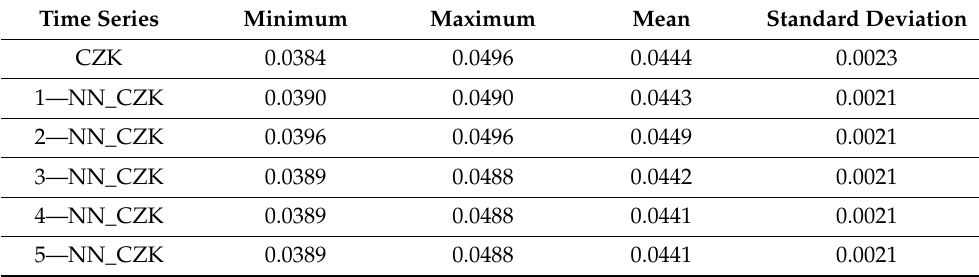
Table 5. Statistical characteristics of smoothed time series and CZK price.